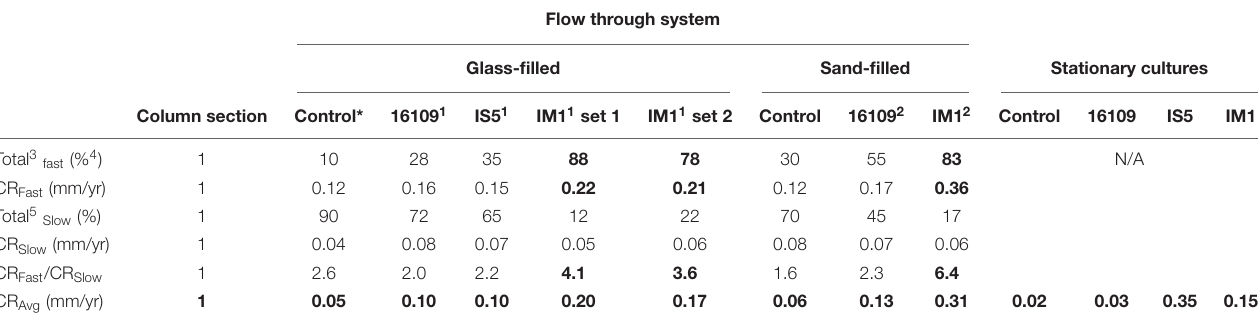
TABLE 1 | Comparison of corrosion rates and distribution between flow-through system (section 1 only) and stationary cultures. Sulfate reducing bacteria ( D. alaskensis and D. ferrophilus IS5) are compared against methanogen ( Methanobacterium IM1). Flow through system Glass-filled Sand-filled Stationary cultures